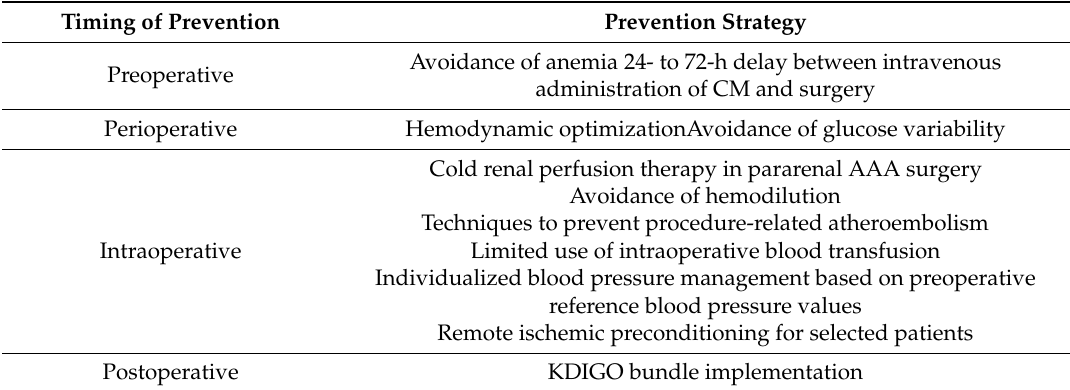
Table 5. Strategies recommended to prevent acute kidney injury (AKI) associated with vascular